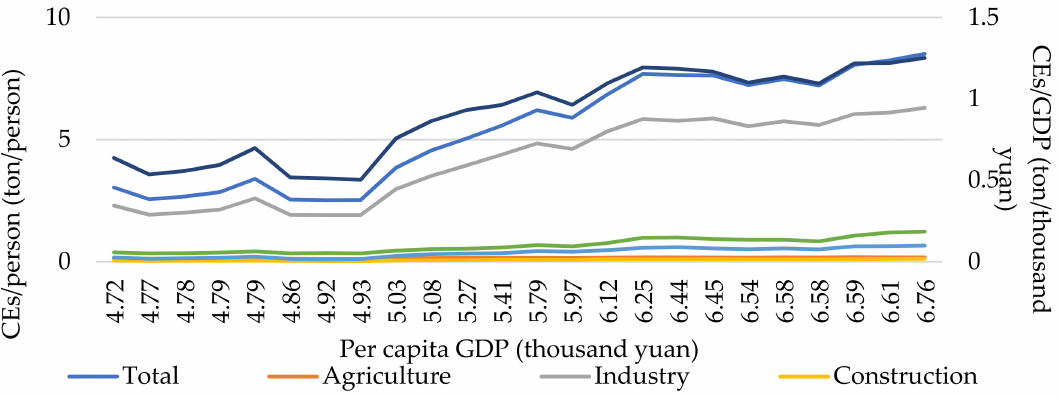
Figure 2. Per capita CEs and per GDP CEs versus per capita GDP.